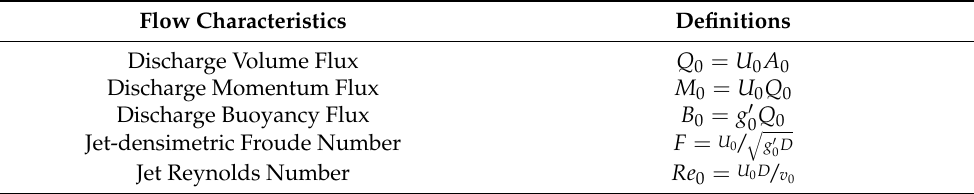
Table 1. Definition of the primary flow characteristics of